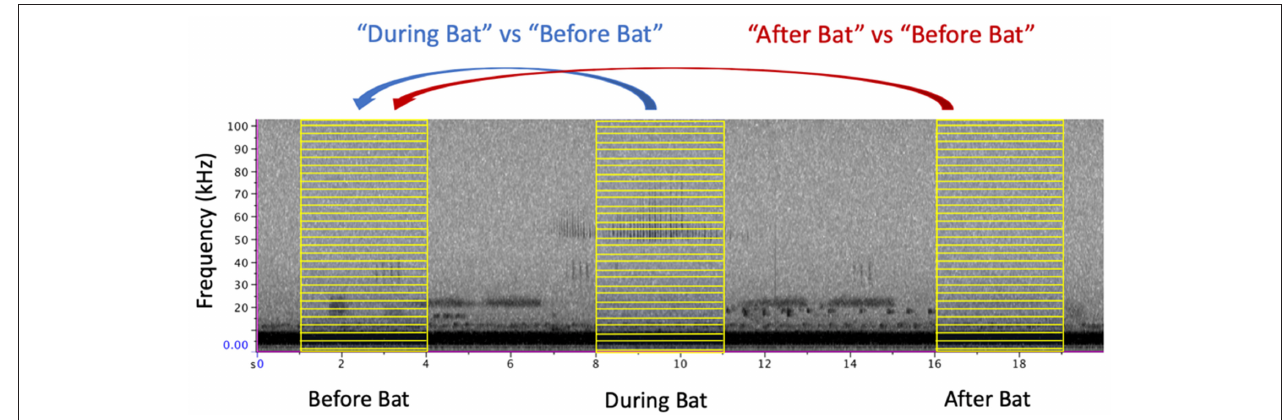
FIGURE 1 | Sample windows were comprised of a 3s window of sound. The “Before Bat” window ended 3s before the first detectible echolocation call and the “After Bat” window began 3s after the last detectible echolocation call. The “During Bat” window was centered on the highest amplitude echolocation call. For clarity of illustration, only a subset of the frequency bins are shown (yellow